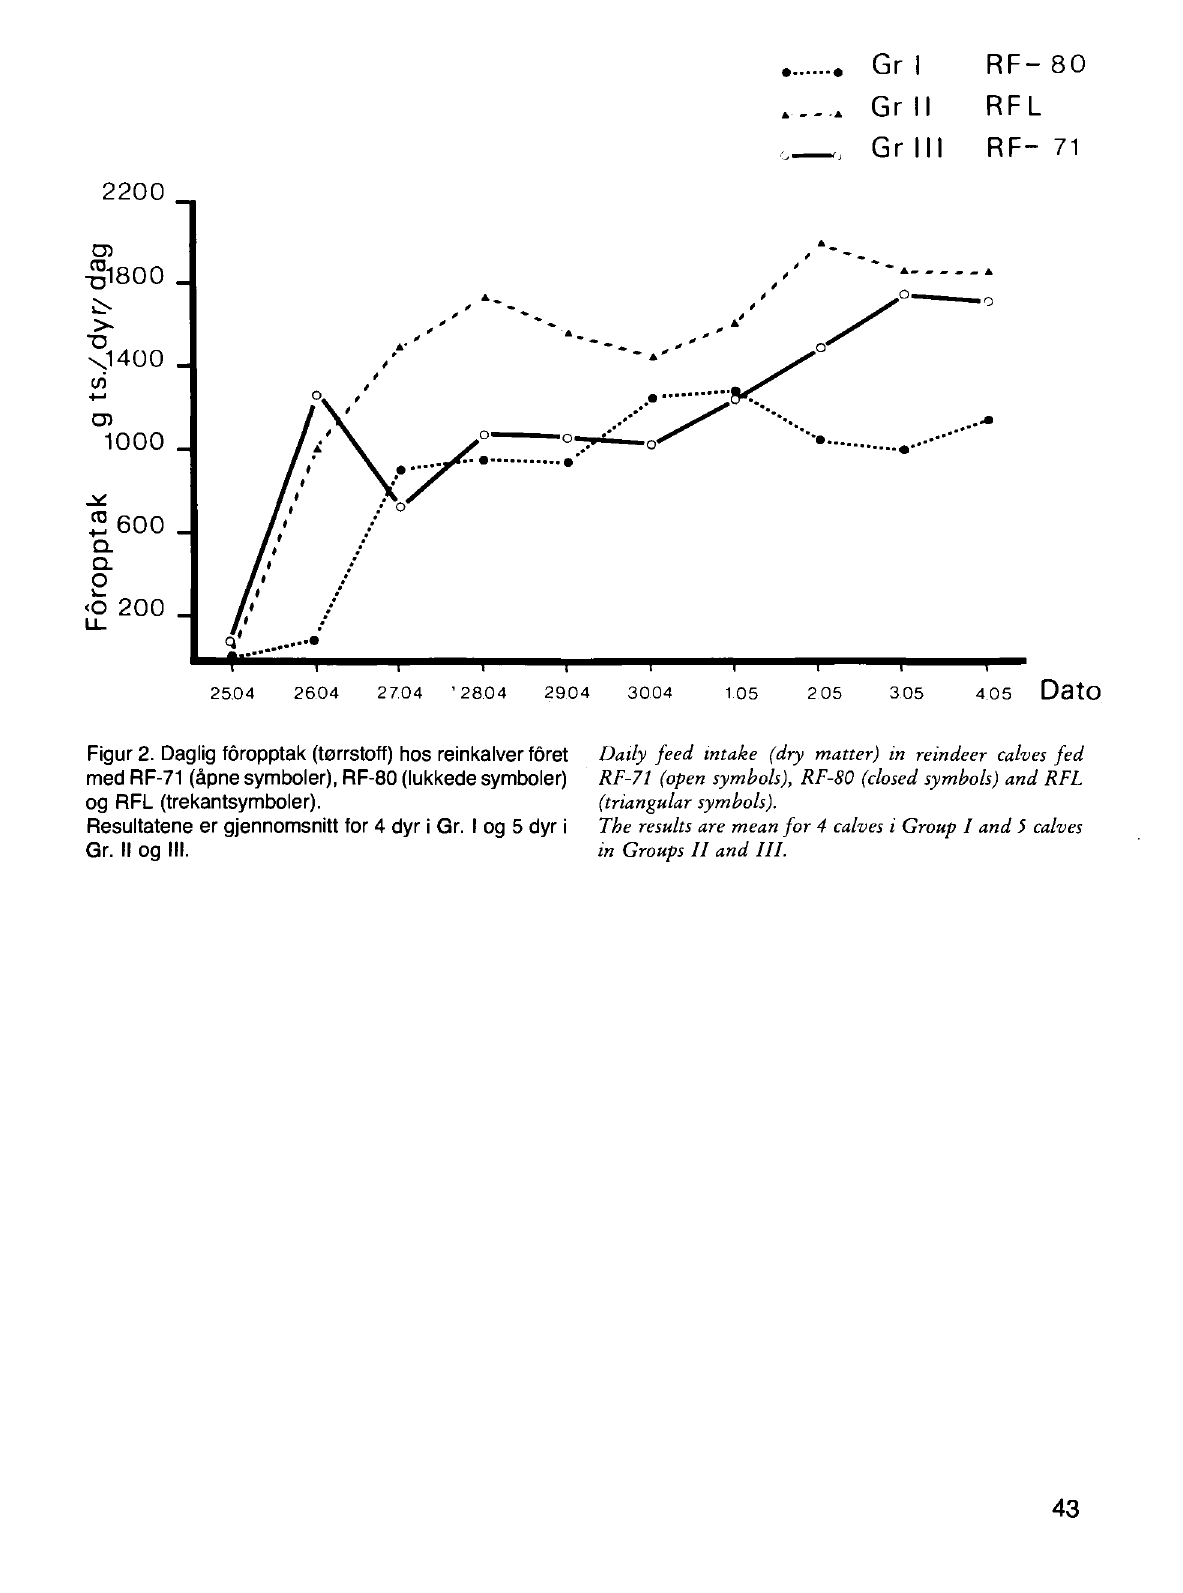
Figur 2. Daglig foropptak (tørrstoff) hos reinkalver foret med RF-71 (åpne symboler), RF-80 (lukkede symboler) og RFL (trekantsymboler). Resultatene er gjennomsnitt for 4 dyr i Gr. I og 5 dyr i Gr. II og